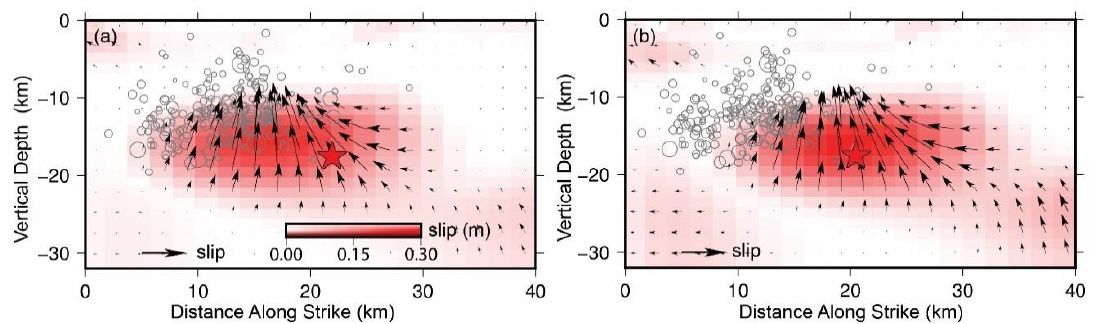
Figure 7. Estimated slip distribution for ( a ) the south dipping model with a strike of 100 ◦ and ( b ) the south dipping model with a strike of 110 ◦ . Red stars denote the main shock epicenter derived from sequence relocation [12]. The x-axis is the distance along the strike direction (units: km) and the y-axis is the vertical depth (units: km).